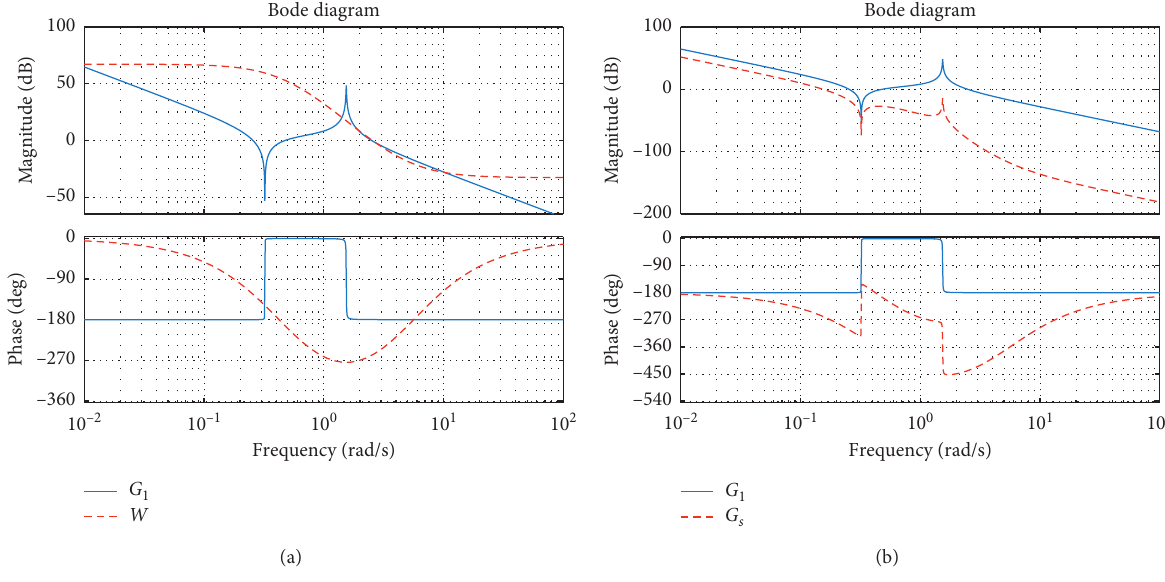
( s ) . (a) G ( s ) and W ( s ) ; (b) G S 1